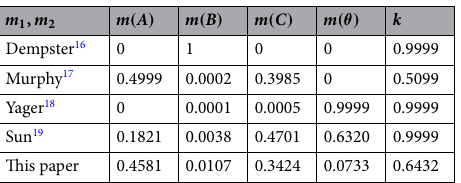
Table 1. The processing results of different algorithms for general conflict problems.